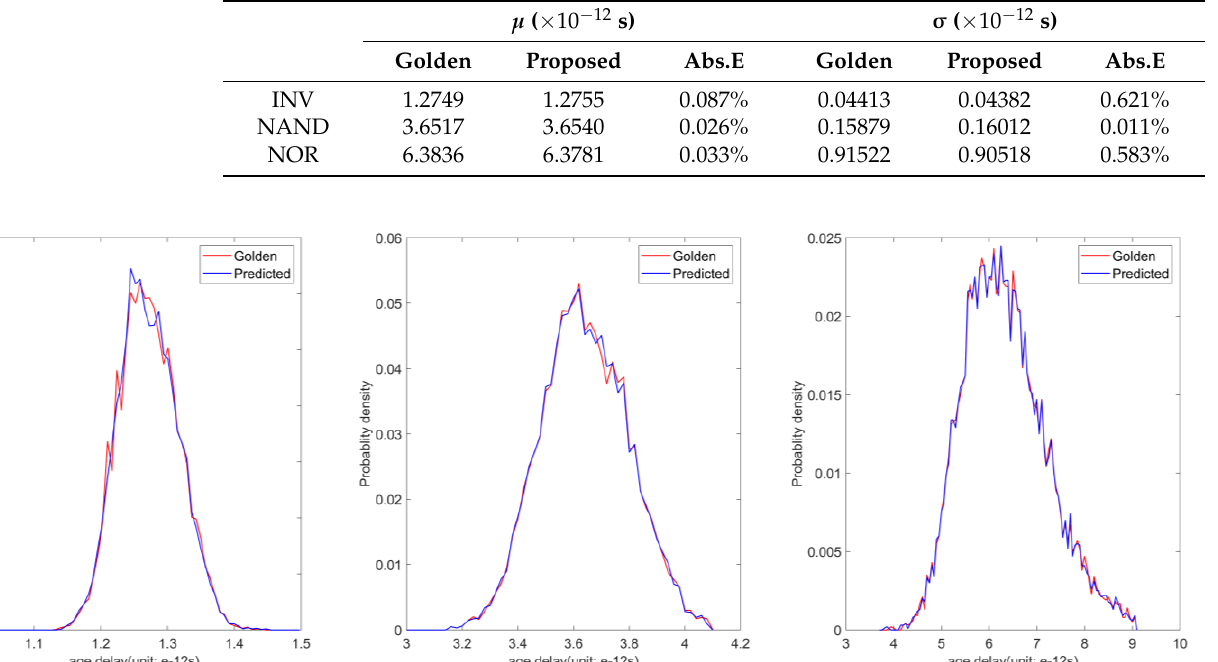
Figure 7. Model prediction accuracy comparison for: ( a ) INV gate; ( b ) NAND2 gate; ( c ) NOR2 gate.